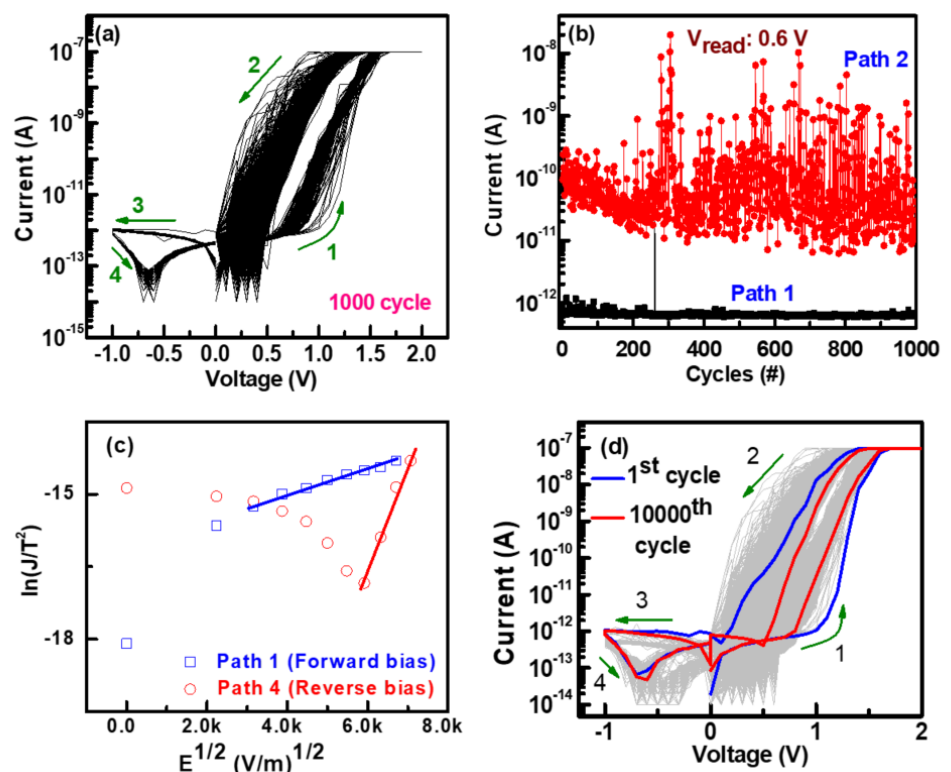
Figure 2. ( a ) Consecutive 1000 switching cycles of the S1 devices at low CC of 100 nA. ( b ) Current vs. no. of cycles plot of path 1 and path 2 at V read of 0.6 V. ( c ) Schottky fitting for path 1 and path 4 at low